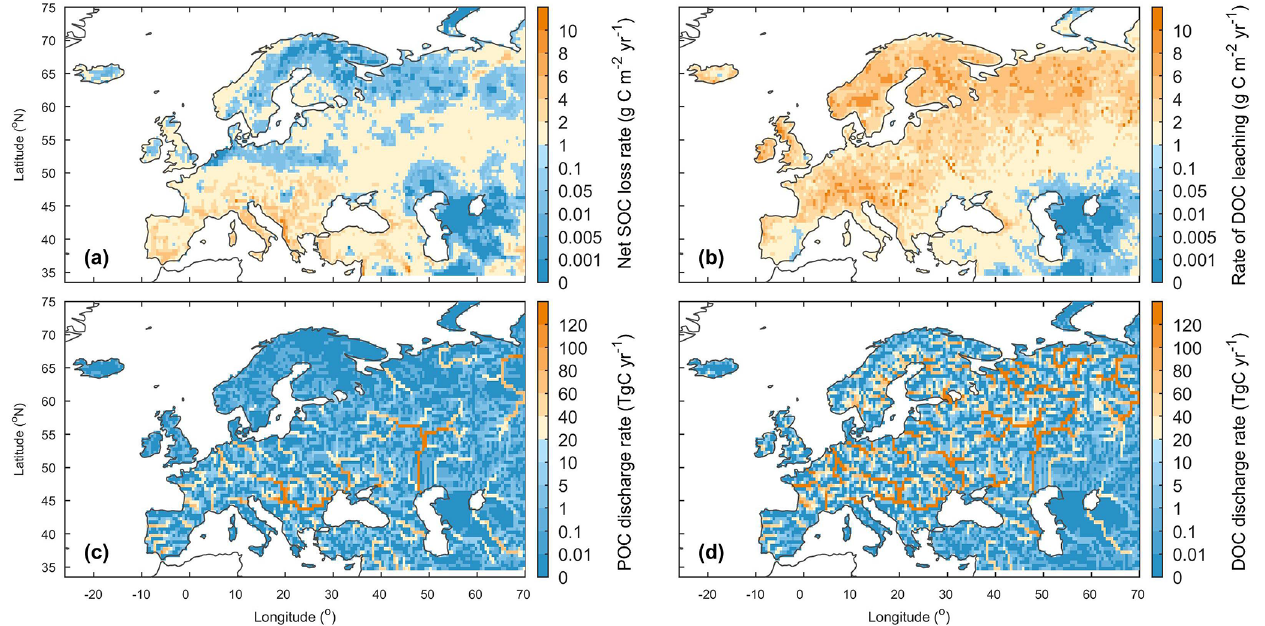
Figure 10. Averaged annual lateral redistribution rate of organic carbon in Europe during 1901–2014. (a) Annual SOC delivery rate from upland to the river network; (b) annual DOC leaching rate; (c) annual POC discharge rate; (d) annual DOC discharge